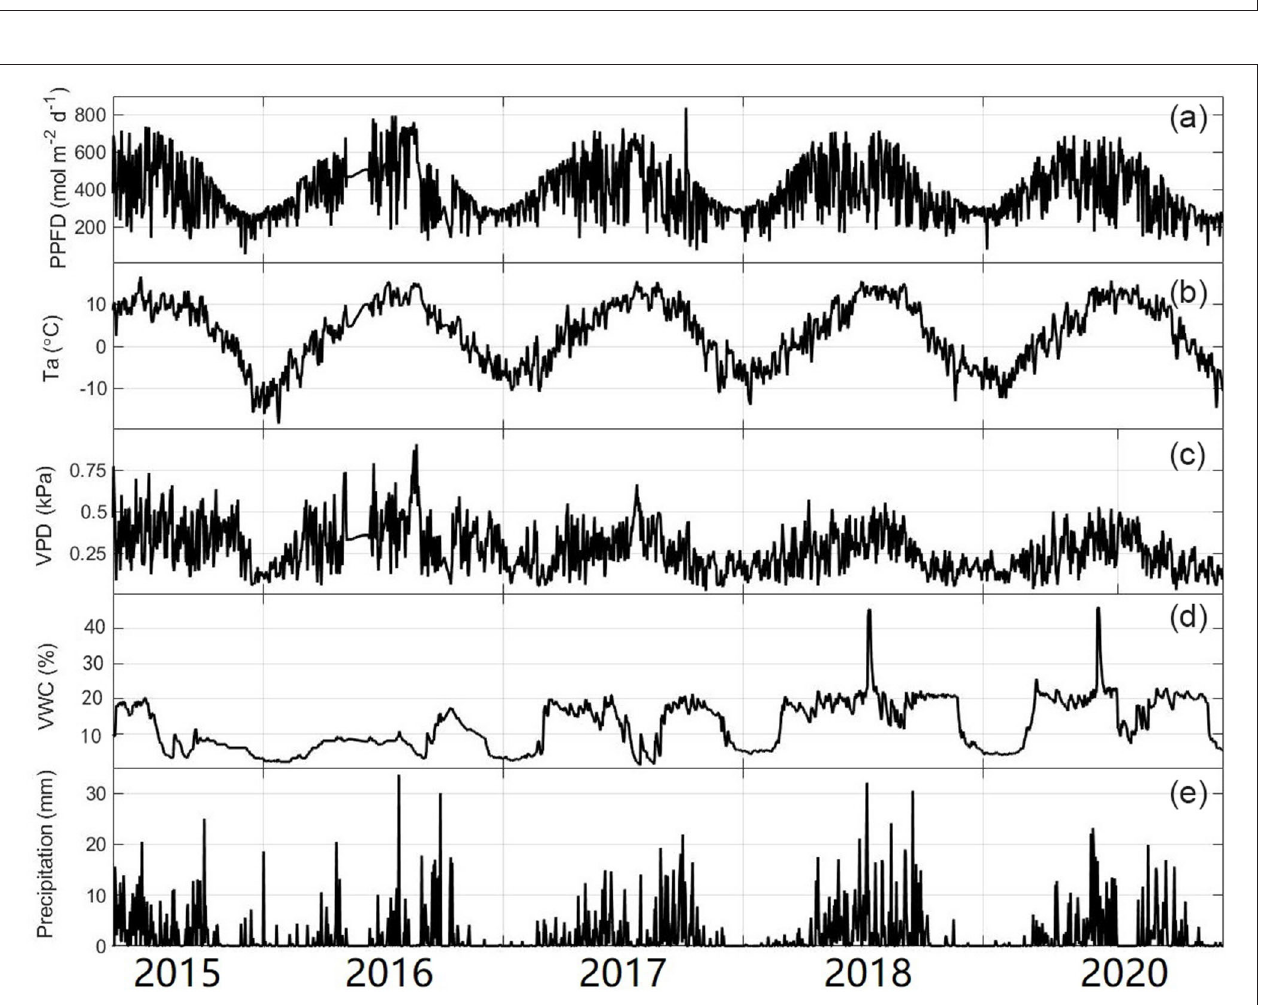
FIGURE 3 | Seasonal variability of (a) photosynthetic photon flux density (PPFD), (b) average daily temperature (Ta), (c) vapor pressure (VPD), (d) volumetric water content (VWC), and (e) daily total precipitation. The lines are plotted from 1 January 1 to 31 December.